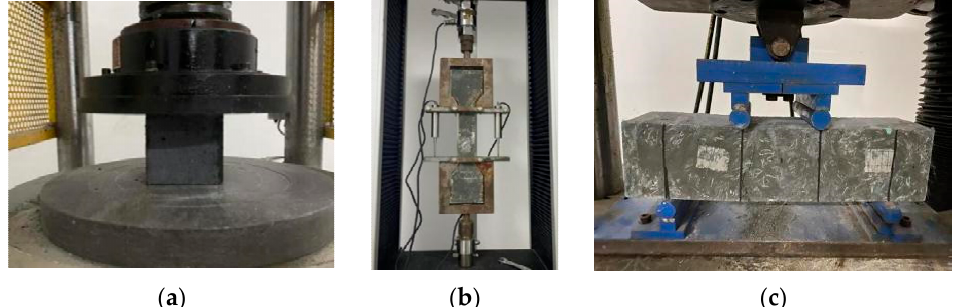
Figure 3. Mechanical property loading test of manufactured sand UHPC. ( a ) Compressive test. ( b ) Uniaxial tensile test. ( c ) Bending test.